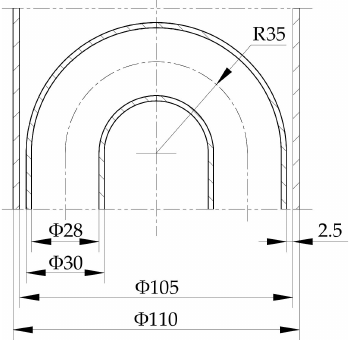
Figure 7. Local geometric dimensions of the siphon pipe and the storage